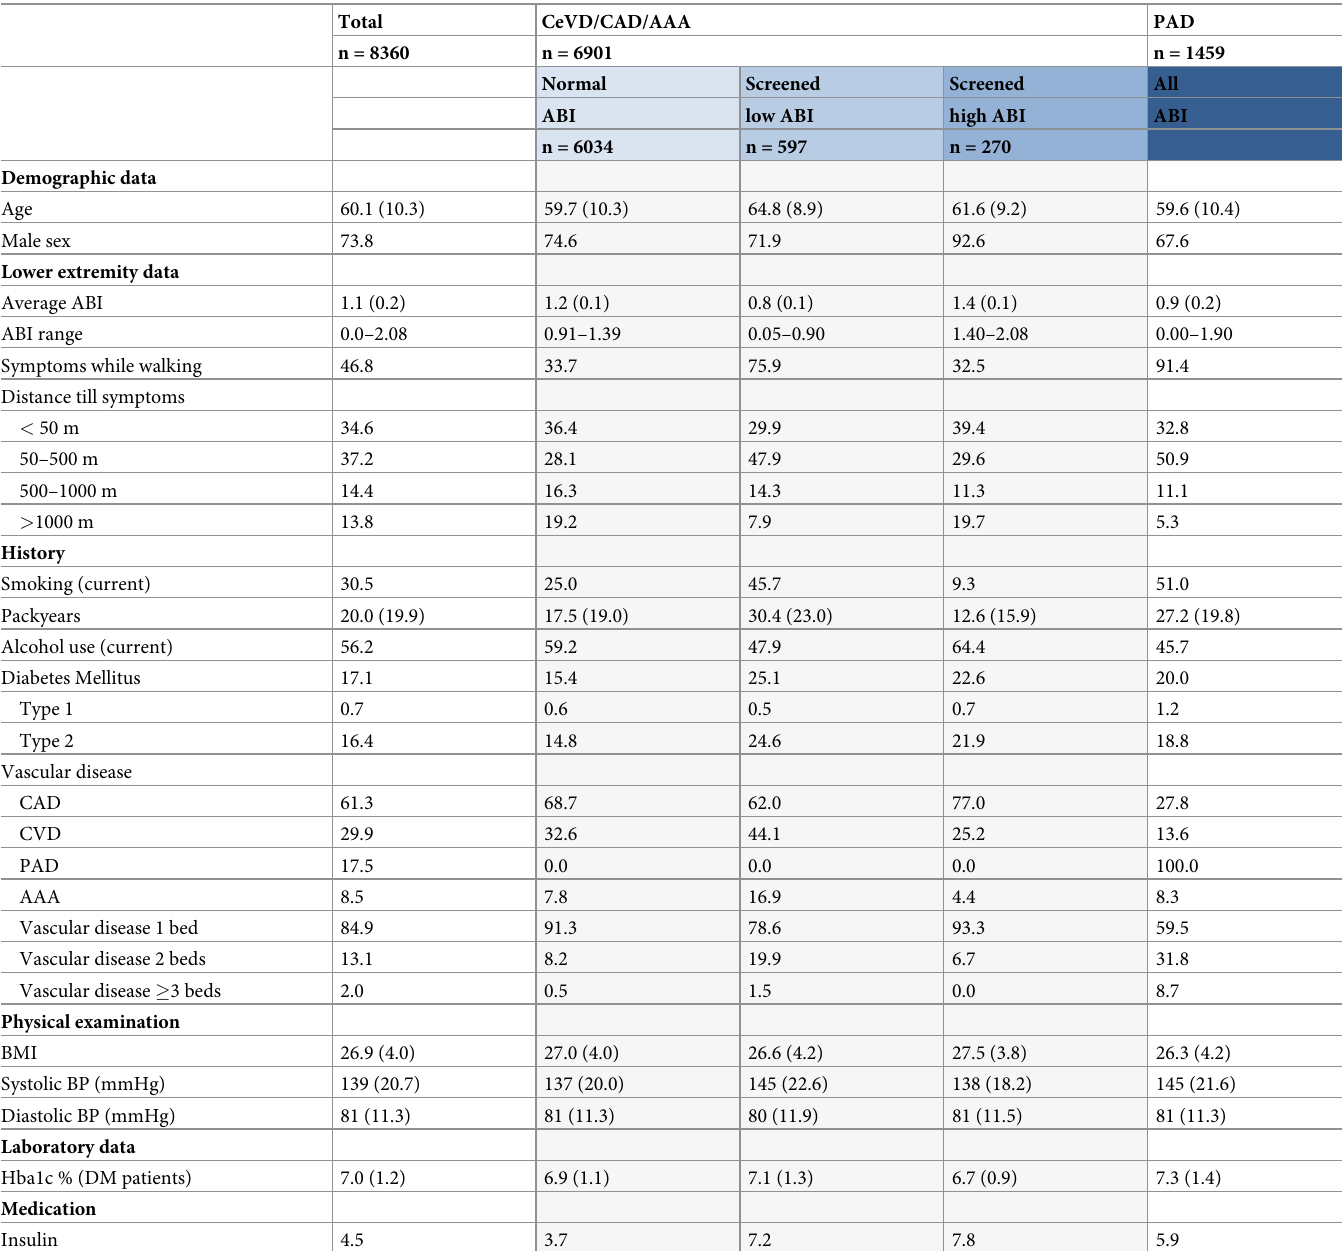
Table 1 shows baseline characteristics of patients with clinical manifest cardiovascular disease. Continuous variables are presented as mean with standard deviation (SD), unless otherwise noted. Categorical variables are presented as percentages. PAD at baseline was defined as manifest peripheral arterial disease at baseline and patients with either screen-detected low or high ABI were not classified as PAD patients at baseline. Vascular disease beds consist of CAD, CeVD, PAD and